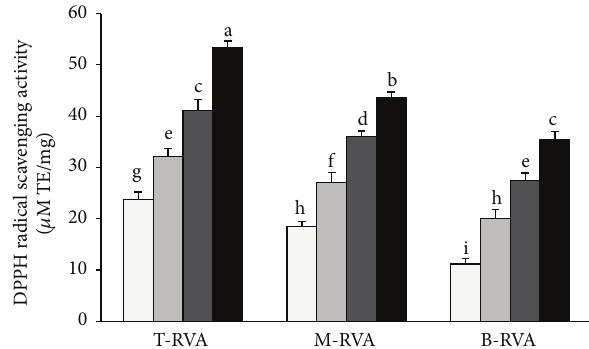
Figure 1: The effect of RVA on DPPH radical scavenging activity. a – i Values not sharing a common letter are significantly different at 𝑃 < 0.05 by Dunnett’s multiple range tests. Light gray square, 125 𝜇 g/mL; gray square, 250 𝜇 g/mL; dark grey square, 500 𝜇 g/mL; black square, 1,000 𝜇 g/mL.